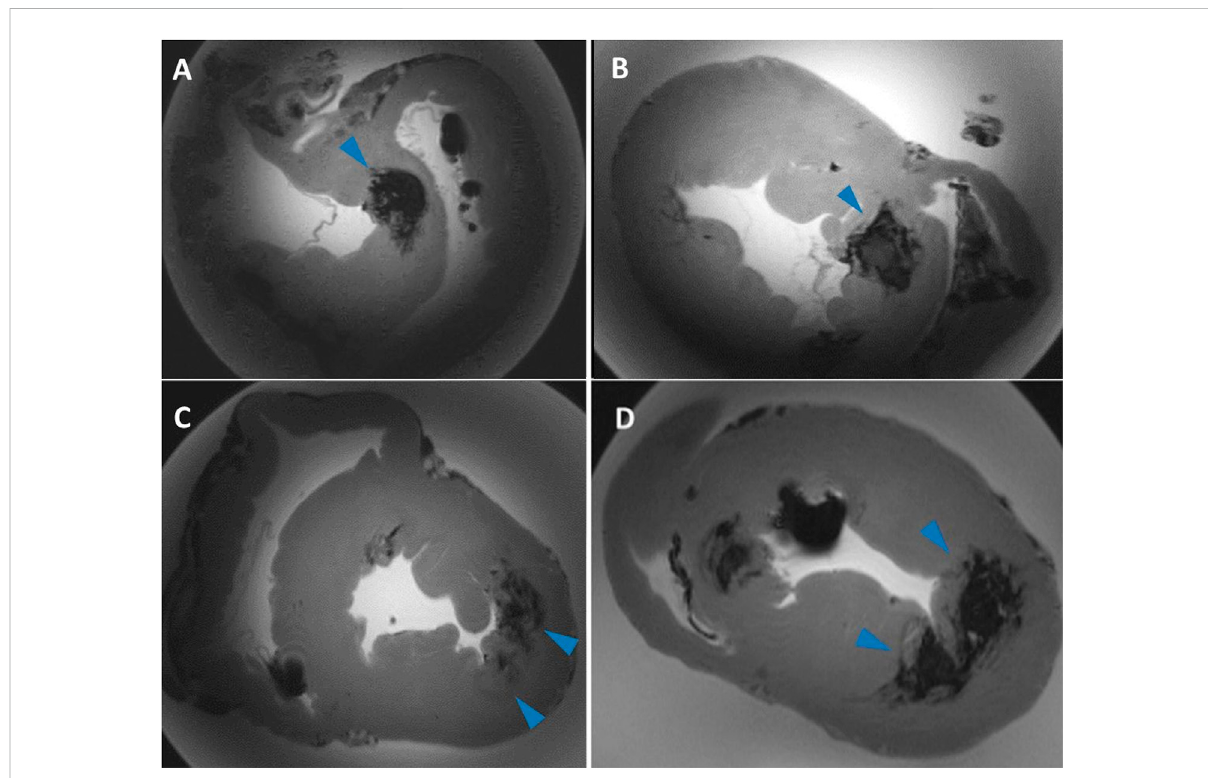
FIGURE 7 Examples of complex lesions. Transverse sections of ventricles of the swine heart on MRI scans. (A,B) shows the irregular shape of lesions with unclear borders. During high energy applications, a “ steam pop ” sometimes occurs, which causes rupture of the myocardial tissue. This rupture spreads into the myocardium and causes irregular and badly bounded lesions. (C,D) example of fused lesions — lesions formed so close each other that they partially merge into